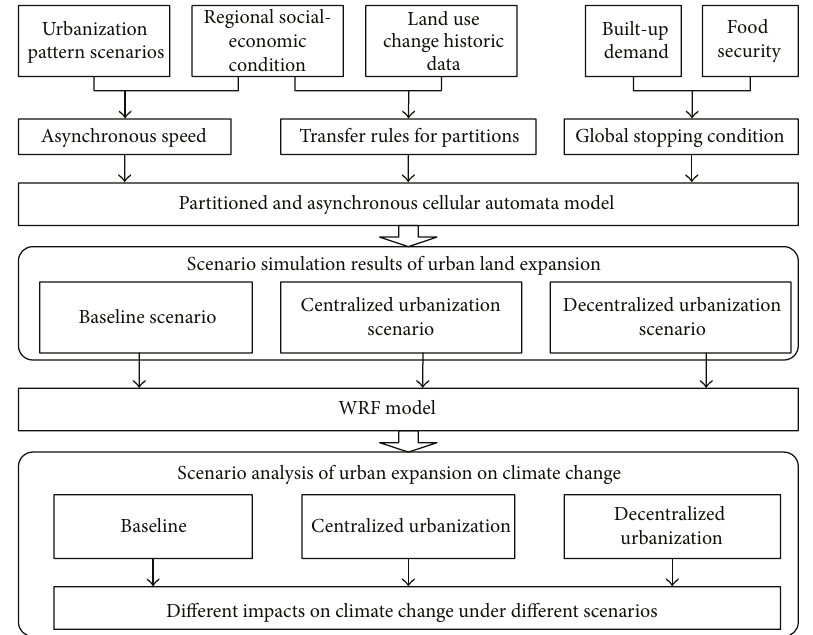
Figure 2: Research framework of scenario analysis of urban land expansion on climate change